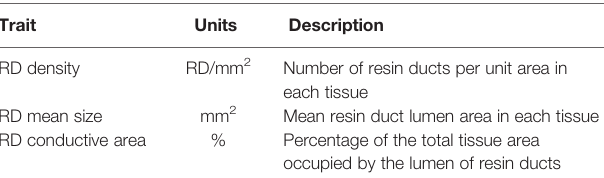
TABLE 1 | Description of resin duct characteristics measured in the xylem and the phloem of Pinus pinaster plants from 10 populations.